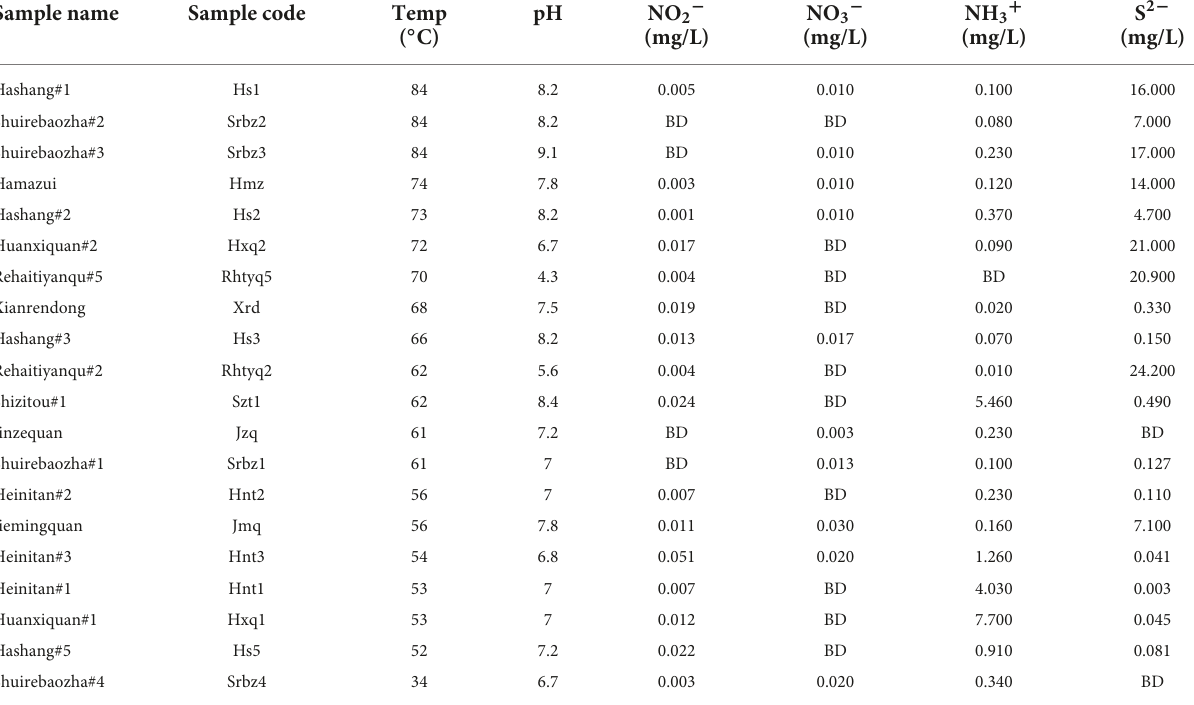
TABLE 1 Physicochemical variables of the investigated hot